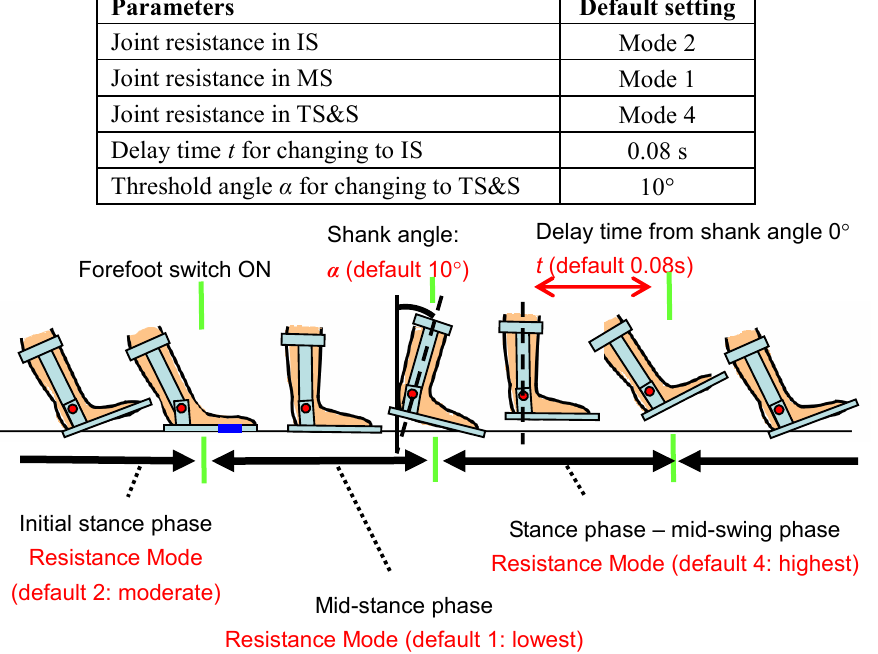
Fig. 5 Summary of the control rules, timings, operation, default settings, and tuning